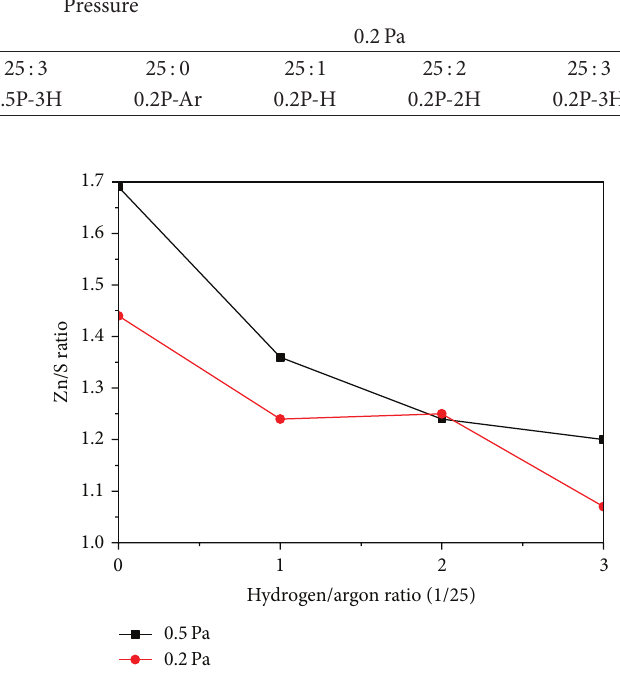
Figure 4: Zn/S ratio of ZnS films deposited in various